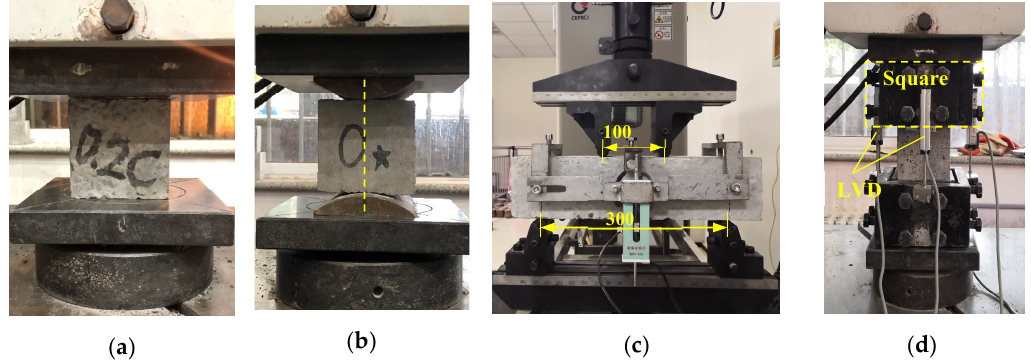
Figure 4. Mechanical property test setup for: ( a ) cube compressive strength, ( b ) splitting tensile strength, ( c ) flexural strength, ( d ) stress–strain curve.